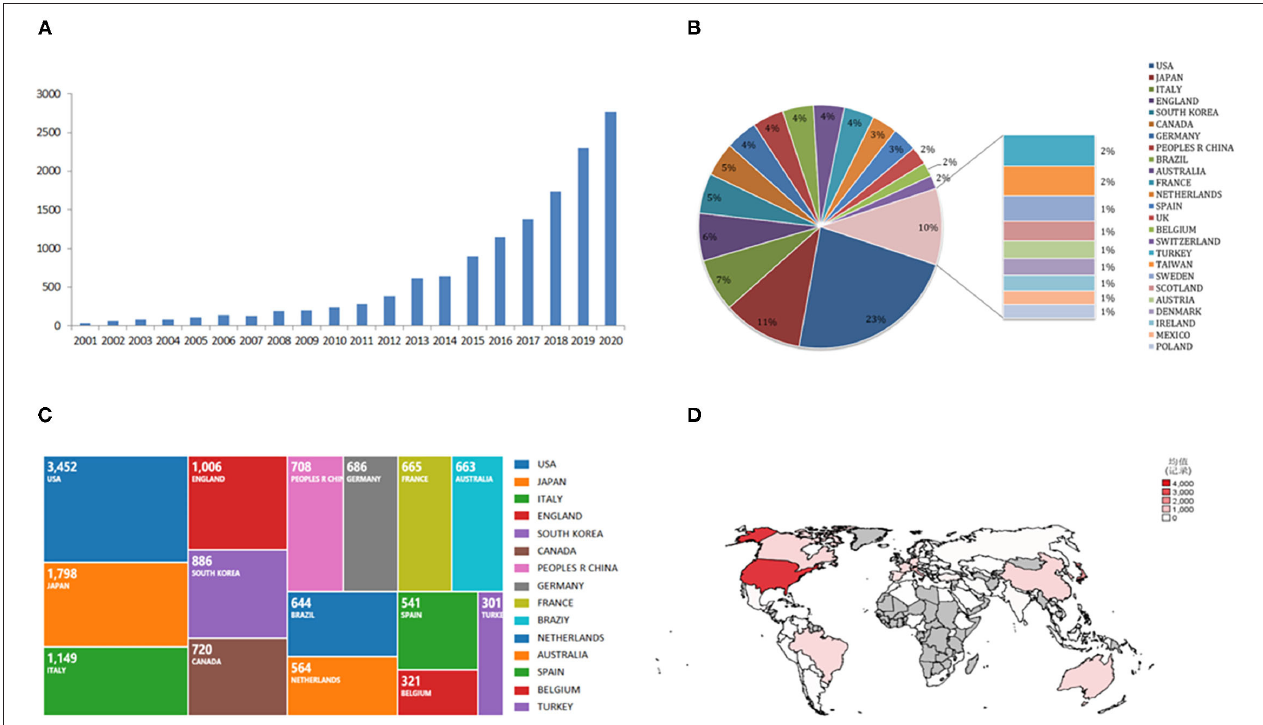
FIGURE 1 | The sarcopenia-related articles globally. (A) A global number of sarcopenia publications per year. Blue bars indicate the number of sarcopenia articles. (B) Percentage of studies from the top 25 countries. (C) Sum of Sarcopenia-related articles from the top 15 countries over time. (D) Heat map showing the distribution of sarcopenia publications in the